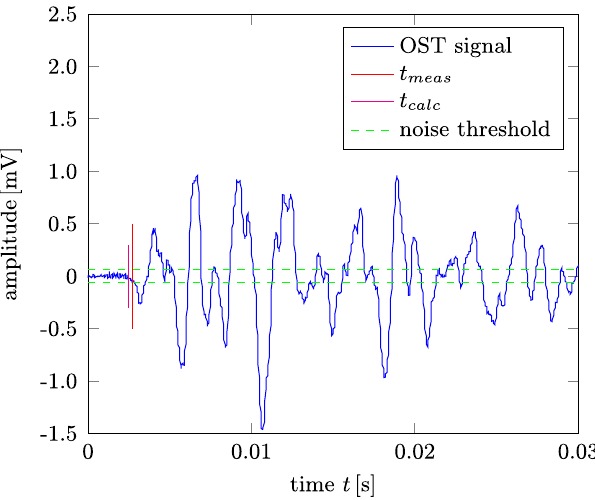
FIG. 10. Starting region of an OST signal. In green the noise band is given, calculated from the measured OST signal prior firing the resistor. The first red line ( t calc ) indicates the position, where the signal is expected theoretically; the second one ( t meas ) gives the position where at first the OST signal crosses the noise